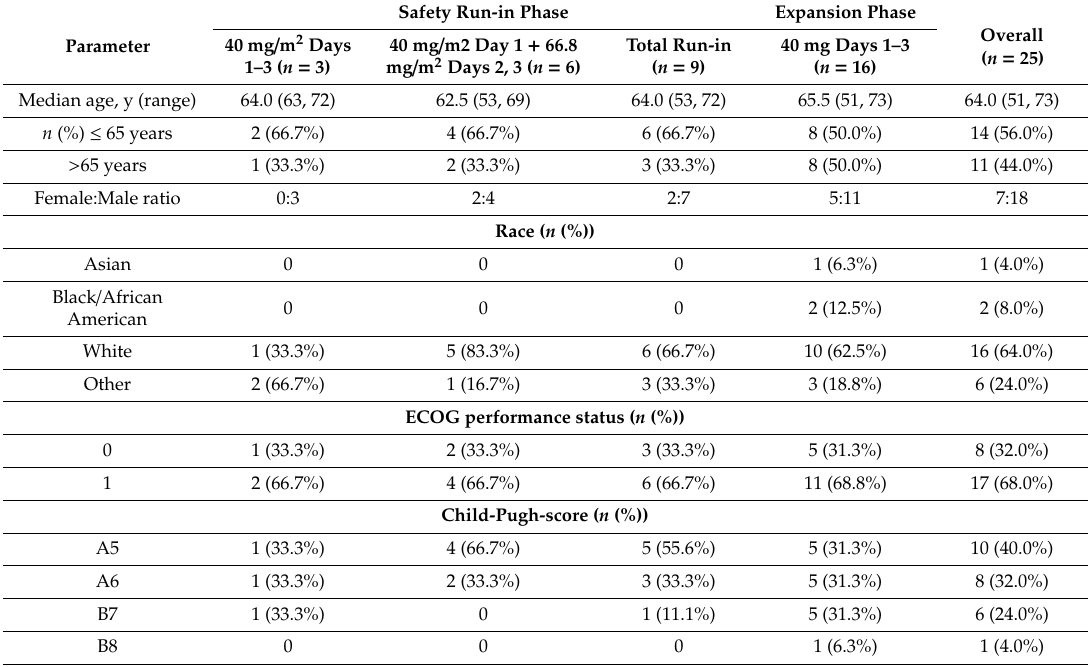
Table 1. Patient baseline demographics and clinical